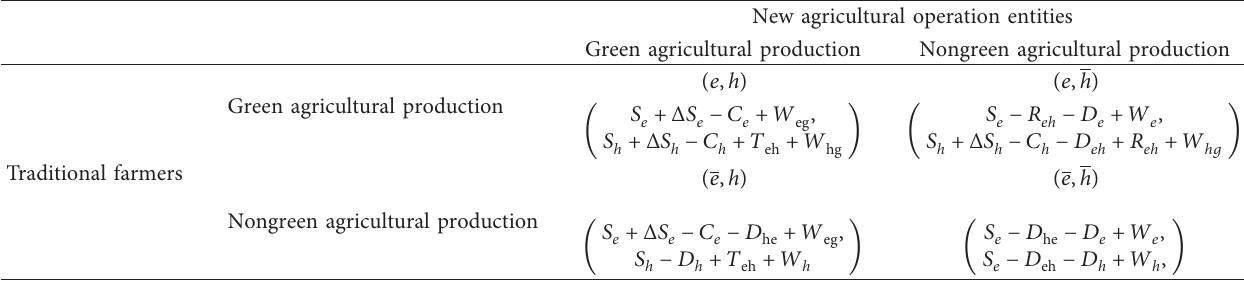
Table 4: The pairwise game matrix between traditional farmers and new agricultural operation entities under the government guidance mechanism.